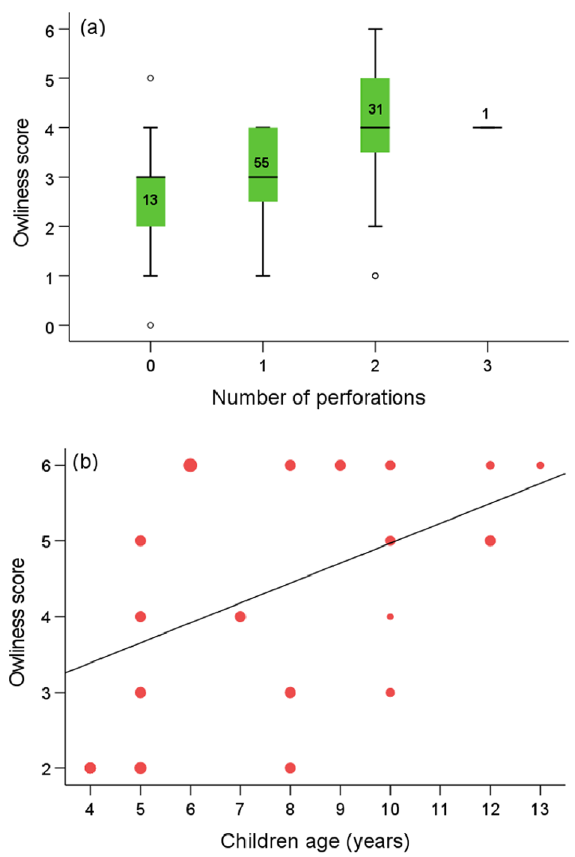
Figure 6. ( a ) Boxplot showing the relationships between the number of perforations and owliness score of a random sample of slate plaques. Numbers inside the box represent sample sizes. ( b ) Relationship between children age and owliness score in a random sample of 100 drawings. The increasing size of multiple markers represents 1, 2, 4, 5, 6, 7 and 12 cases, respectively. Least squares regression line of the correlation is shown for graphical representation of